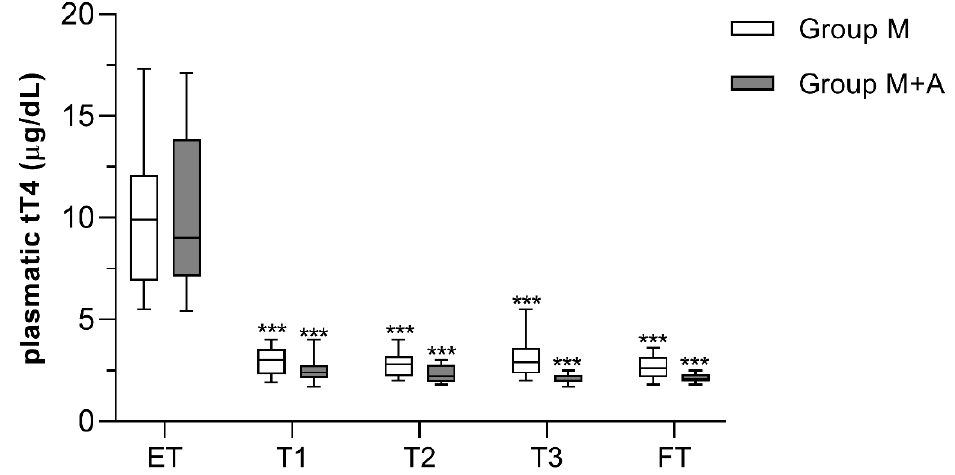
Figure 2. Total plasma T4 (tT4) concentrations in hyperthyroid cats receiving methimazole and placebo (group M, n = 14), or methimazole and antioxidants (group M + A, n = 16). Asterisks indicate statistically significant di ff erences compared to ET (*** p < 0.001). Statistical analysis was performed by two-way ANOVA for repeated measures followed by Sidak’s post-hoc test. ET = enrollment time; T1 = 15 days; T2 = 30 days; T3 = 90 days; FT = finish time (180